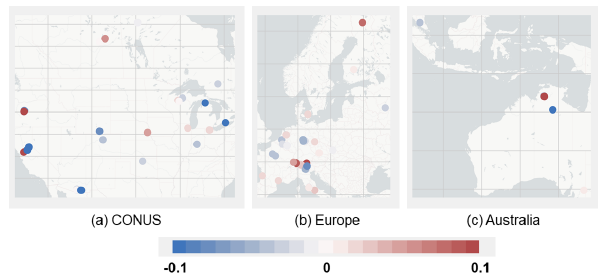
Figure 16. Standardized anomaly correlation ( R AN ) difference of the surface latent heat flux between ERA5-Land and ERA5 with respect to eddy-covariance data. Blue colours indicate that the anomaly correlation of ERA5-Land with respect to eddy-covariance measurements is higher than for ERA5, whereas red colours indi- cate the